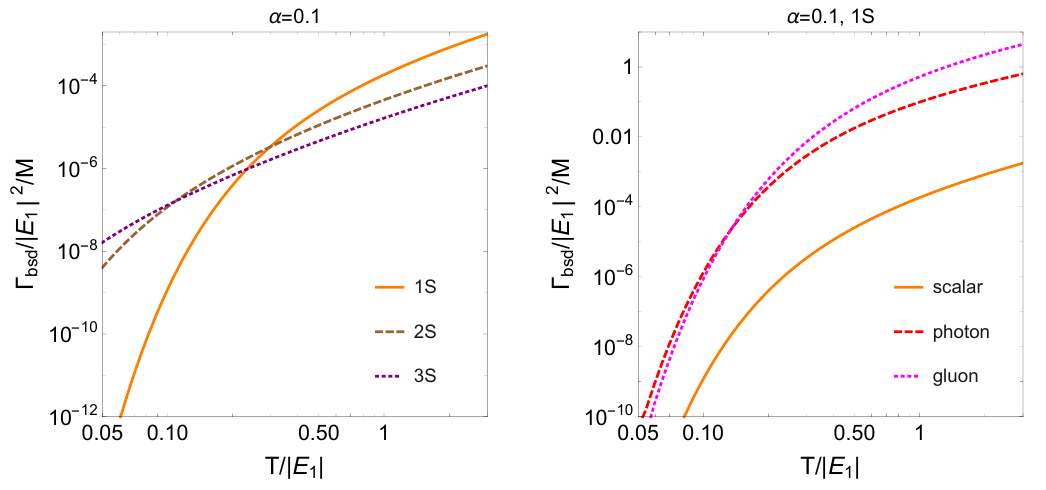
Figure 8 . (Left) Thermal width of the bound states, normalized by | E 1 | 2 /M , for the | 1 S i , | 2 S i and | 3 S i states. We fixed α = 0 . 1 . (Right) Comparison among the thermal widths induced by a scalar, photon and gluon (with N c = 3 in eq. (3.18)) for the ground